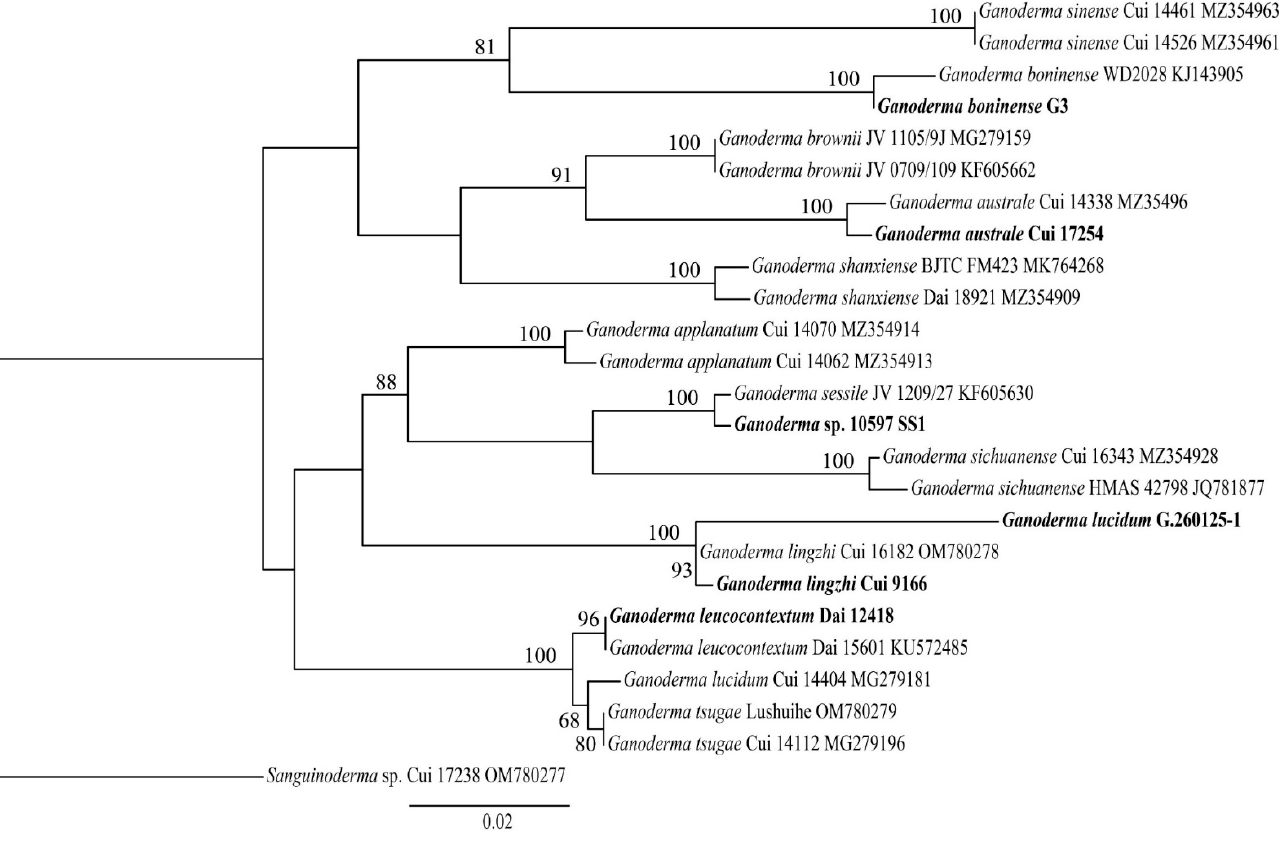
Figure 2. ML analyses of 12 Ganoderma strains based on ITS sequences. ML bootstrap values higher than 50% are shown. Stains with sequenced genomes are shown in bold.